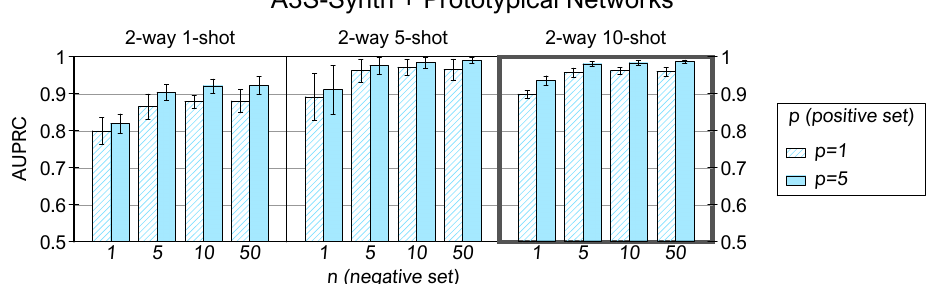
Figure 8. AUPRC results for prototypical networks trained and tested with A3S-Synth in several ( C , K , p , n )